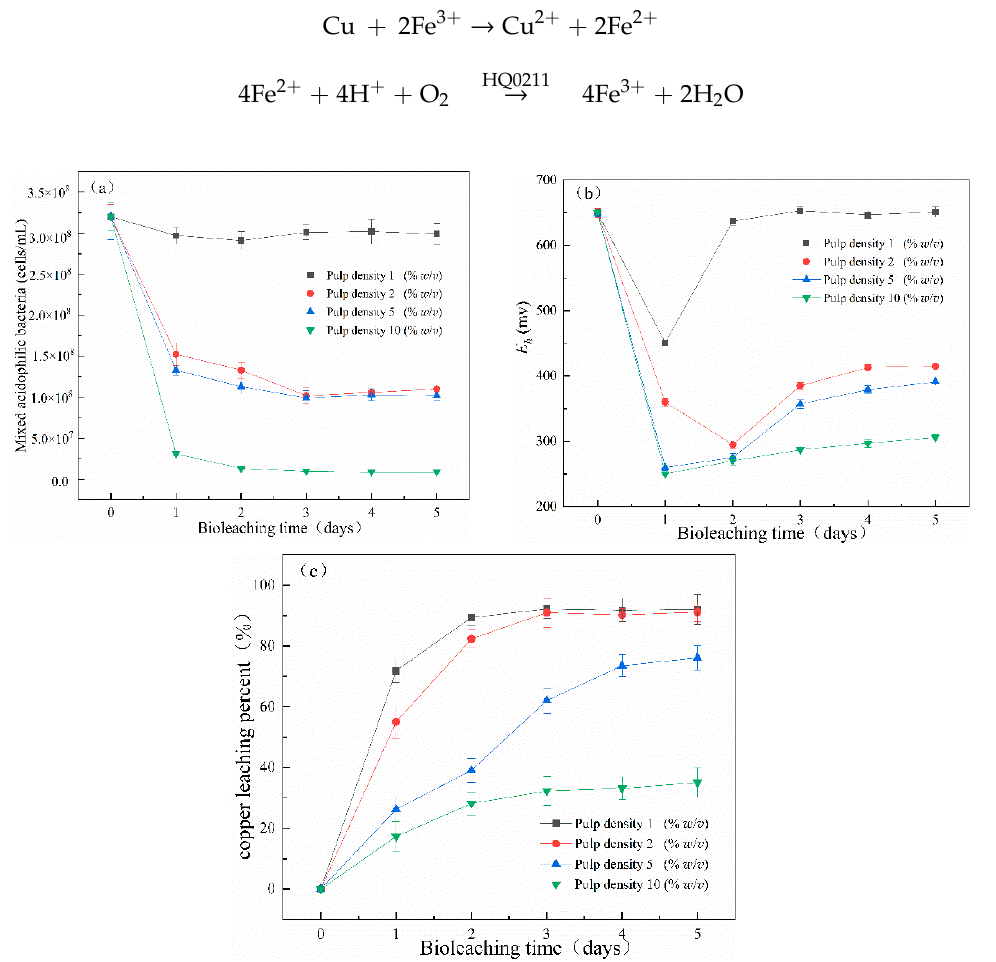
Figure 7. ( a ) Cell concentration, ( b ) redox potential, and ( c ) copper-leaching percentage (mean ± SD) during copper bioleaching at different WPCB pulp densities (other conditions: 1.6 pH, 45 °C, 170